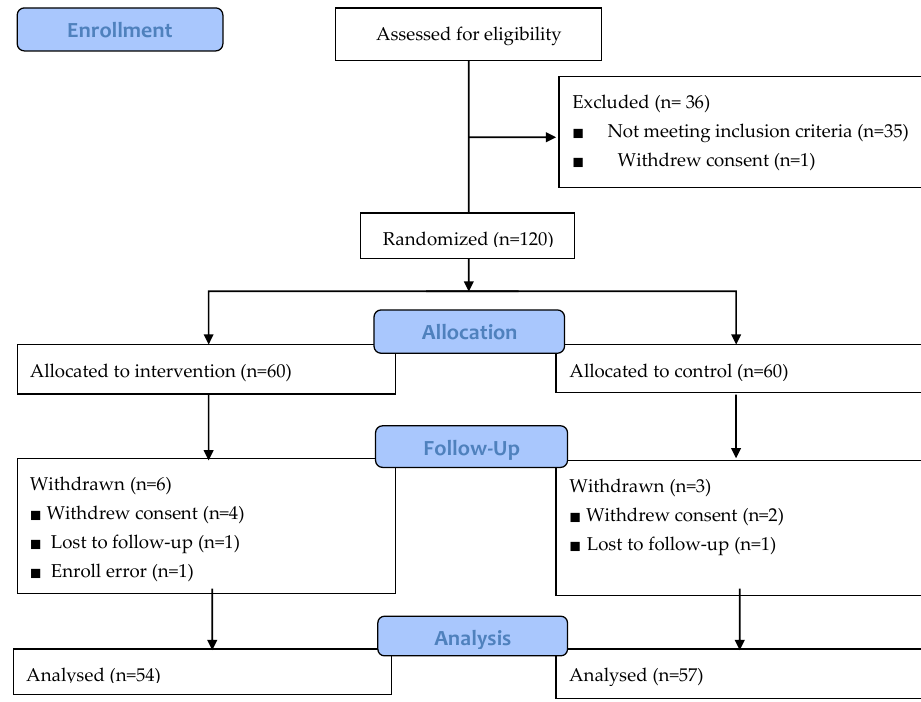
Figure 1. Flow chart of the study population.